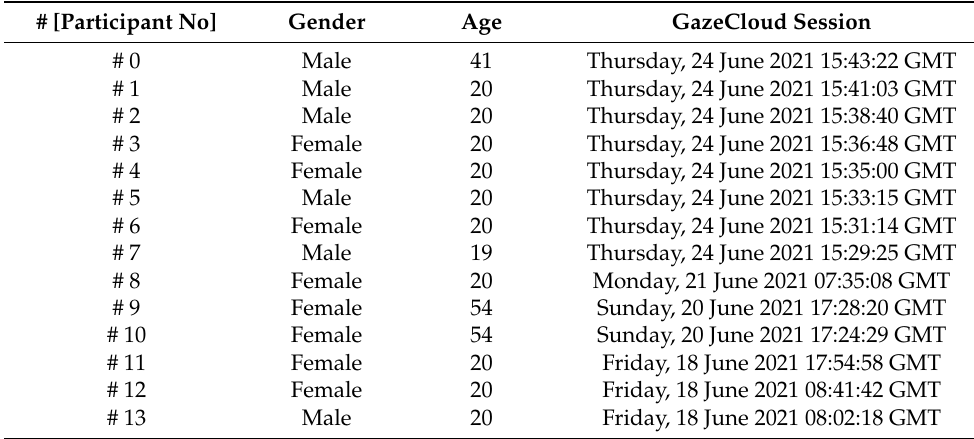
Table A1. The fact sheet of all of the